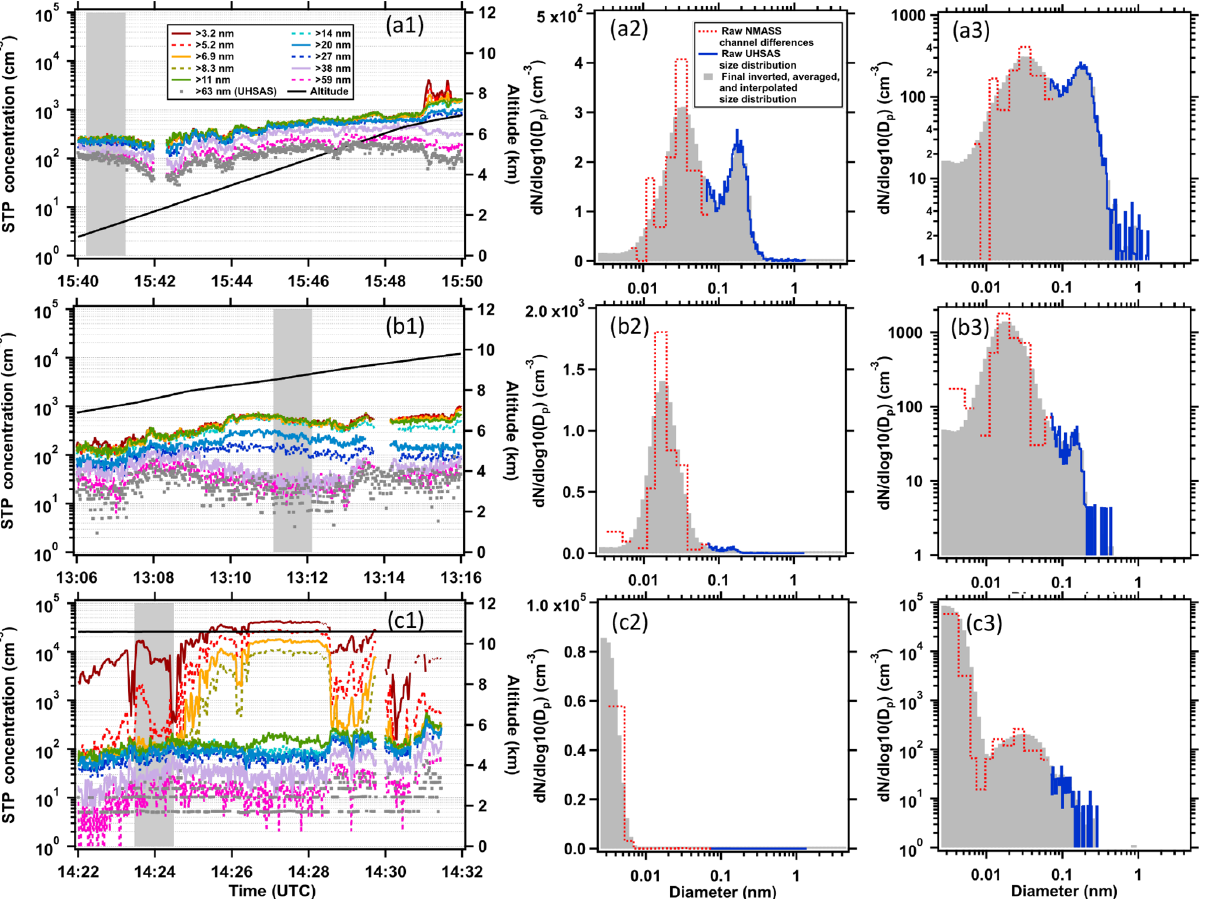
Figure 6. Panels (a1) , (b1) , and (c1) show three example time plots of STP concentrations measured by each channel of the two NMASS instruments and by the non-thermodenuded UHSAS on 13 February 2017 on a flight over the South Atlantic Ocean between Punta Arenas, Chile (43.2 ◦ S, 70.9 ◦ W), and Ascension Island, UK (7.9 ◦ S, 14.3 ◦ W). Each plot shows 10min of flight time and uses the same scales, and the cases were chosen to show how size distributions dominated by different modes are measured. “Striping” of the UHSAS concentrations in (b1) and (c1) are caused by poor 1s counting statistics at low concentrations. Panels (a2) , (b2) , and (c2) show linear particle number size distributions averaged over the 1min interval shown by the grey shading in (a1) , (b1) , and (c1) , respectively. These size distributions show raw NMASS size distributions (dashed red curve) obtained by simple differencing of adjacent CPC channels using the 50% efficiency values of each CPC response curve (Fig. 2). Negative differences between the channels are shown as gaps in the curve. The solid blue curve shows the raw UHSAS size distribution, which is reported in 99 channels. The shaded histogram shows the combined final data, composed of the inverted NMASS data and the time-averaged and size-interpolated UHSAS and LAS data as reported in the ATom archive using 20 constant logarithmic size bins per decade of diameter. Panels (a3) , (b3) , and (b3) show the same size distributions plotted using a logarithmic y axis to illustrate the accumulation mode